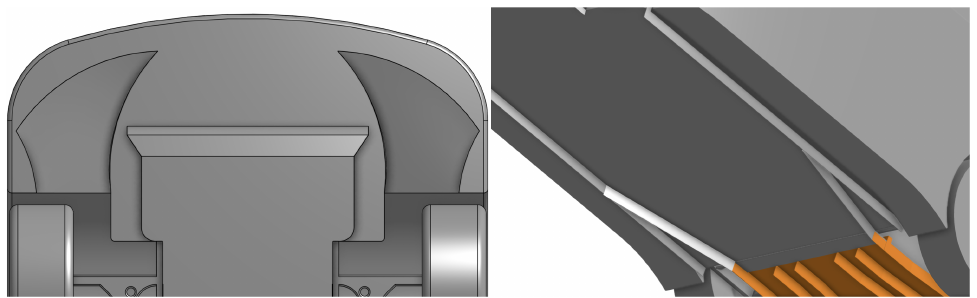
Figure 10. Side and rear view of the diffuser mounted on any of the configurations with additions.